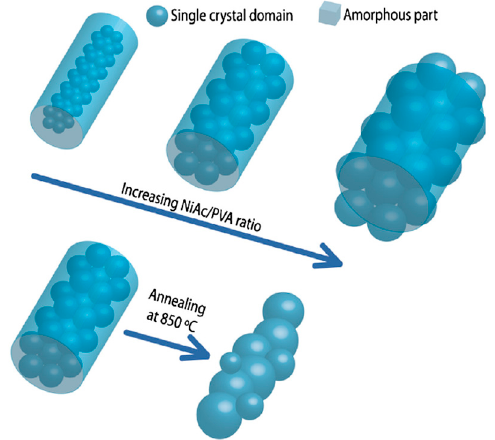
Figure 5. Schematic illustration of microstructural evolution in NiO NFs as a function of NiAc/PVA ratio and high temperature calcination. Reprinted with permission from Ref. [99]. Copyright © 2009 Elsevier Ltd. and Techna Group